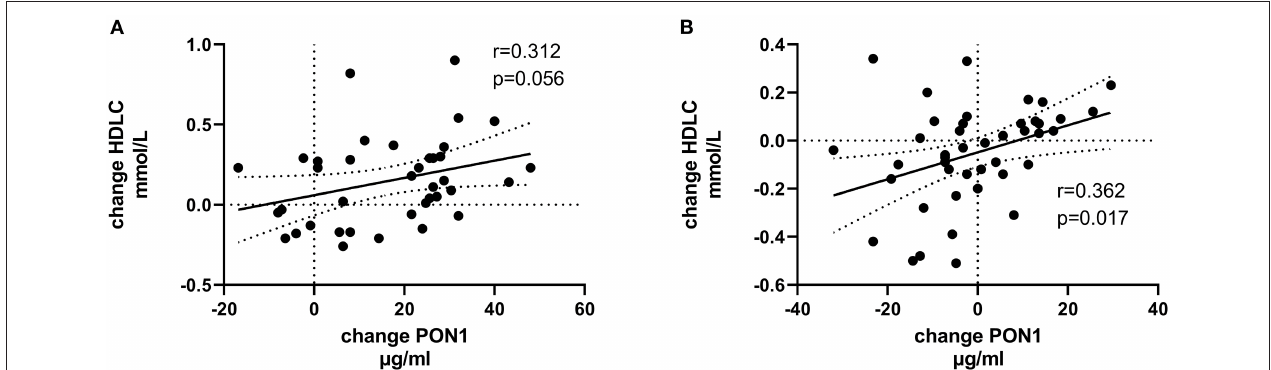
FIGURE 1 | Change in HDLC vs. change in PON1 mass. (A) Transplant group. (B) Dialysis group.